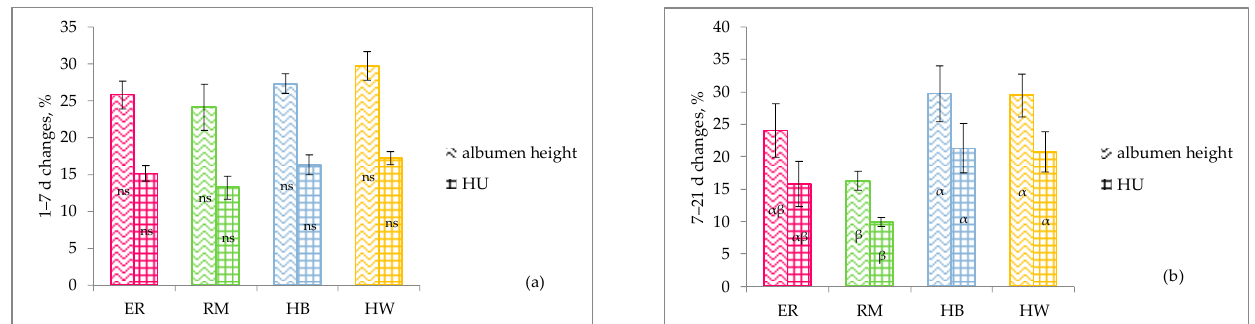
Figure 4. Effect of genotype 1 on changes (%, lsmeans ± SE) of albumen height 2 and Haugh Units 3 (HU) from 1 to 7 days ( a ) and from 7 to 21 days ( b ) of storage. Different letters among similar columns (trait, expressed as loss) indicate different values: α , β : p < 0.10. ns: no significance. 1 Genotype: ER: Ermellinata di Rovigo; RM: Robusta maculata; HB: Hy-Line Brown; HW: Hy-Line White 36. 2, 3 Observations ( n ) for all the genotpes: 4 (at each age).